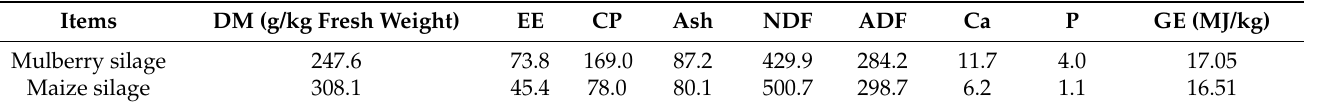
Table 2. Nutrient composition of mulberry and maize silages (g/kg DM, except where other- wise